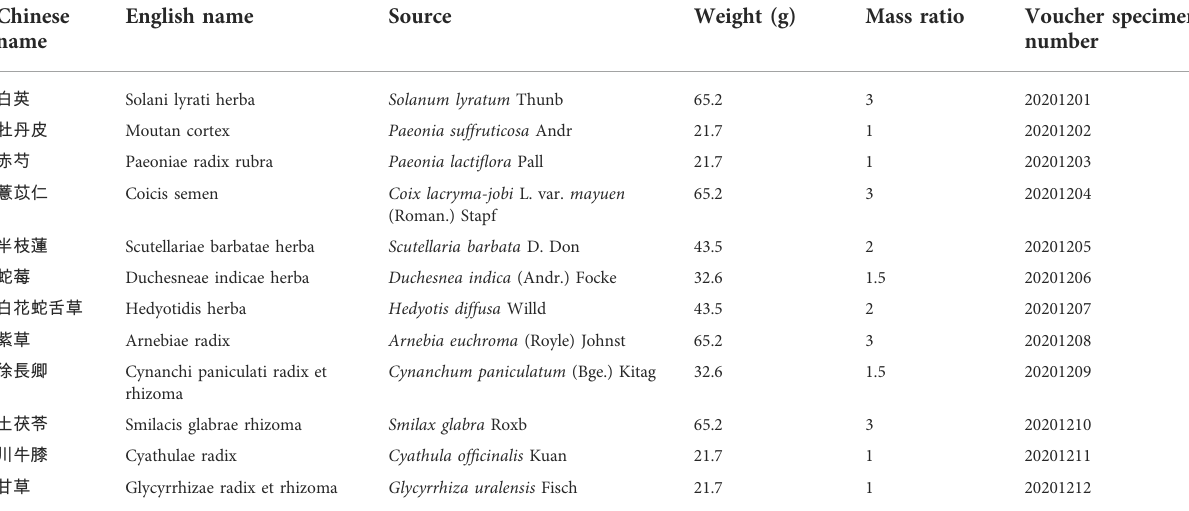
TABLE 1 composition of baiying qingmai